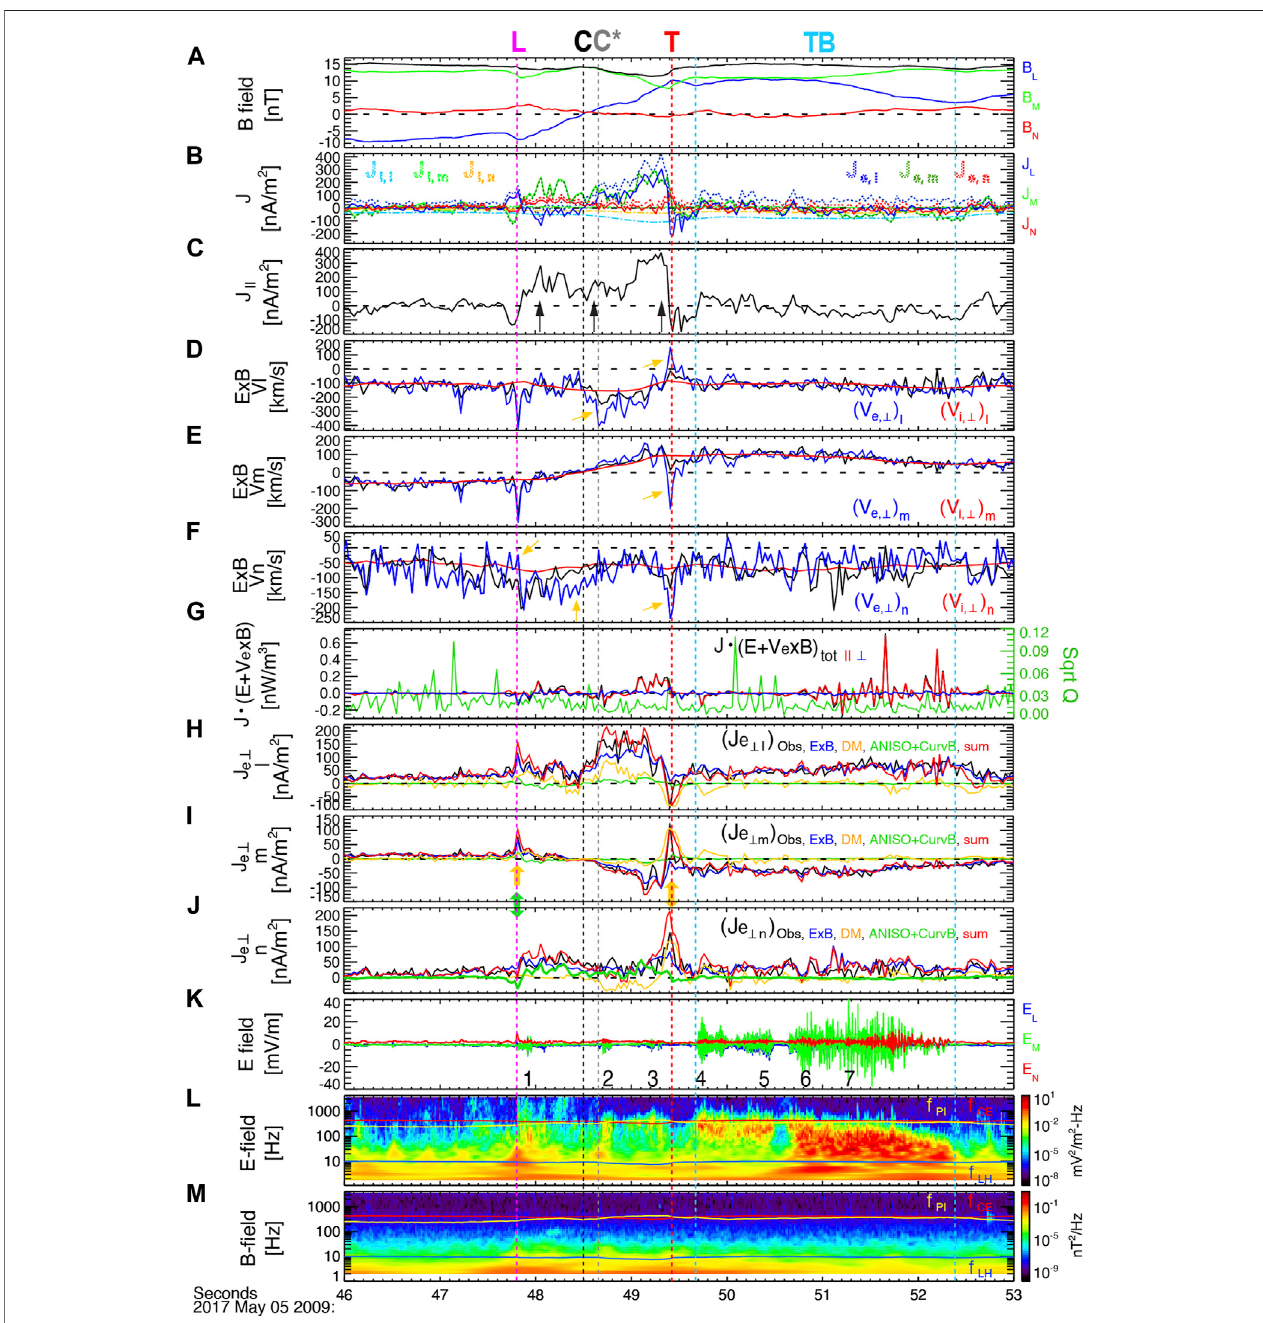
FIGURE4| MMS1observationonMay52017during2009:46 – 53UT: (A) the l (blue), m (green),and n (red)componentsof B ; (B) the l , m ,and n componentsofthe current density (J) calculated from both ion and electron moments (solid blue, green, and red pro fi les), the ion current (dot-dashed blue, green, and orange), and the electroncurrent(dottedblue,darkgreen,andorange); (C) thecurrentdensityparallelto B ; (D – F) the l , m ,and n componentsofthe E × B drift(black)togetherwiththeion (red)andelectron (blue)velocitiesperpendicularto B ; (G) Jouledissipationintheelectronframe, J · ( E + V e × B ) showninblack,blue,andredpro fi lesrepresenting (cid:1)(cid:1) √ the total, parallel, and perpendicular components to B , and Q (green) quantifying the level of departures from gyrotropy using electron pressure tensors (Swisdak, 2016); (H – J) the l , m , and n components of the electron perpendicular current, J e , ⊥ (black), compared with those of the electron E × B current ( − en e E × B electrondiamagneticcurrent( B × ∇ P e , ⊥ ,orange),andtheelectronanisotropycurrenttakingintoaccountthein fl uenceofcurvaturedrifts ( P e , || − P e , ⊥ ) B ×( B · ∇ ) B B 2 l , m , and n components of E ; (L,M) the power spectral density (PSD) of E (L) and B (M) .